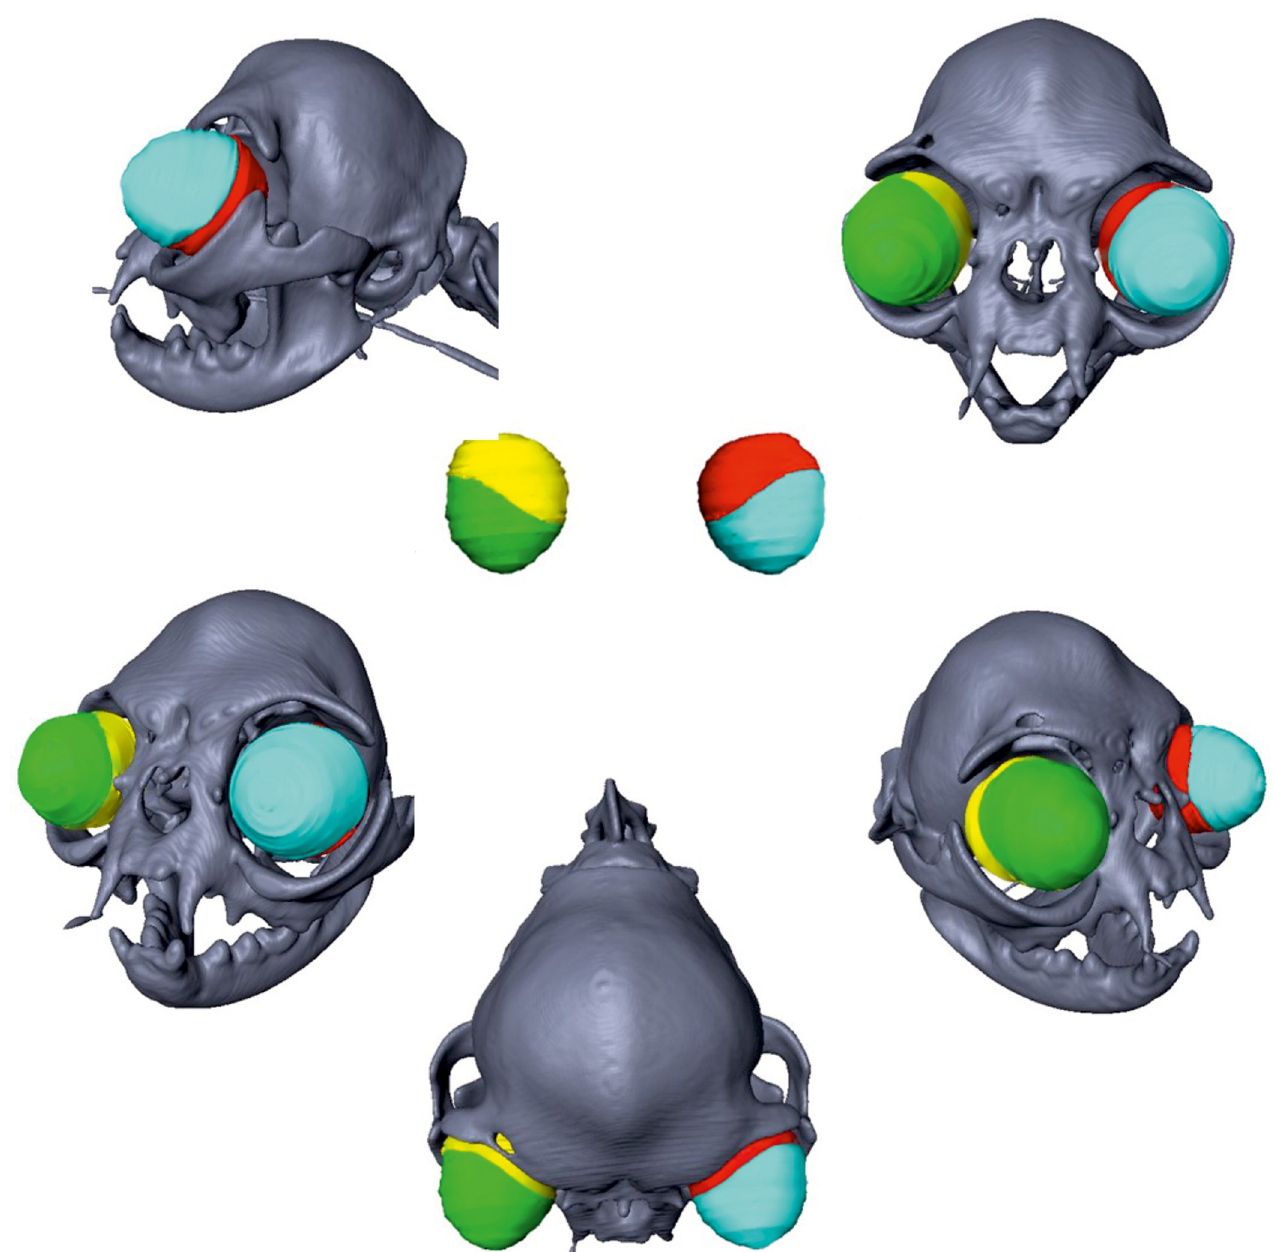
Fig 13. Reconstruction of the extra-orbital part of the eye globes in a Persian cat. Three-dimensional reconstructions of an extreme brachycephalic Persian in the right column. The different parts of the eye globes are marked in different colours: yellow = intra-orbital part of the right eye; green = extra-orbital part of the right eye; red = intra-orbital part of the left eye; blue = extra-orbital part of the left eye. The extremely exposed position of the bulbi in the Persian is evident.